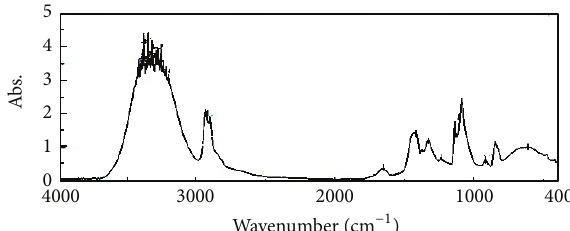
Figure 2: Absorption spectra of pure PVA obtained from FTIR in the range 4000–400 cm −1 recorded at room temperature. The peaks show the resonance wavenumber of pure PVA.